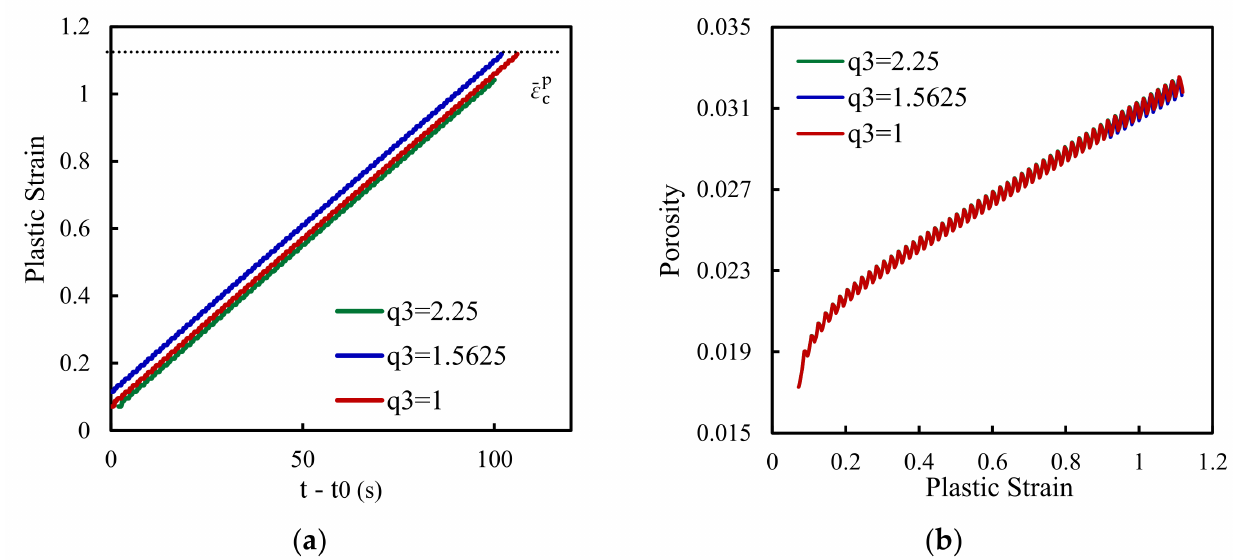
Figure 12. ( a ) Plastic strain evolution in terms of the distinct values of q 3 . ( b ) Porosity evolution, due to the increase in plastic strain, for the same values of q 3 previously referred. Results are shown in natural